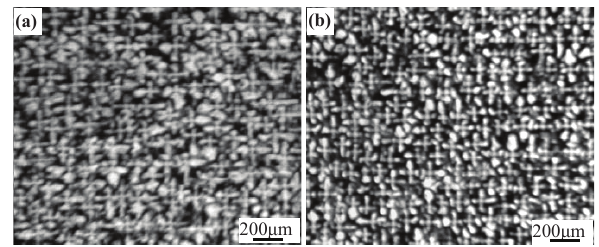
Figure 1. Dendrite morphologies of the as-cast alloys 1 and 2. (a) Alloy 1, (b) alloy